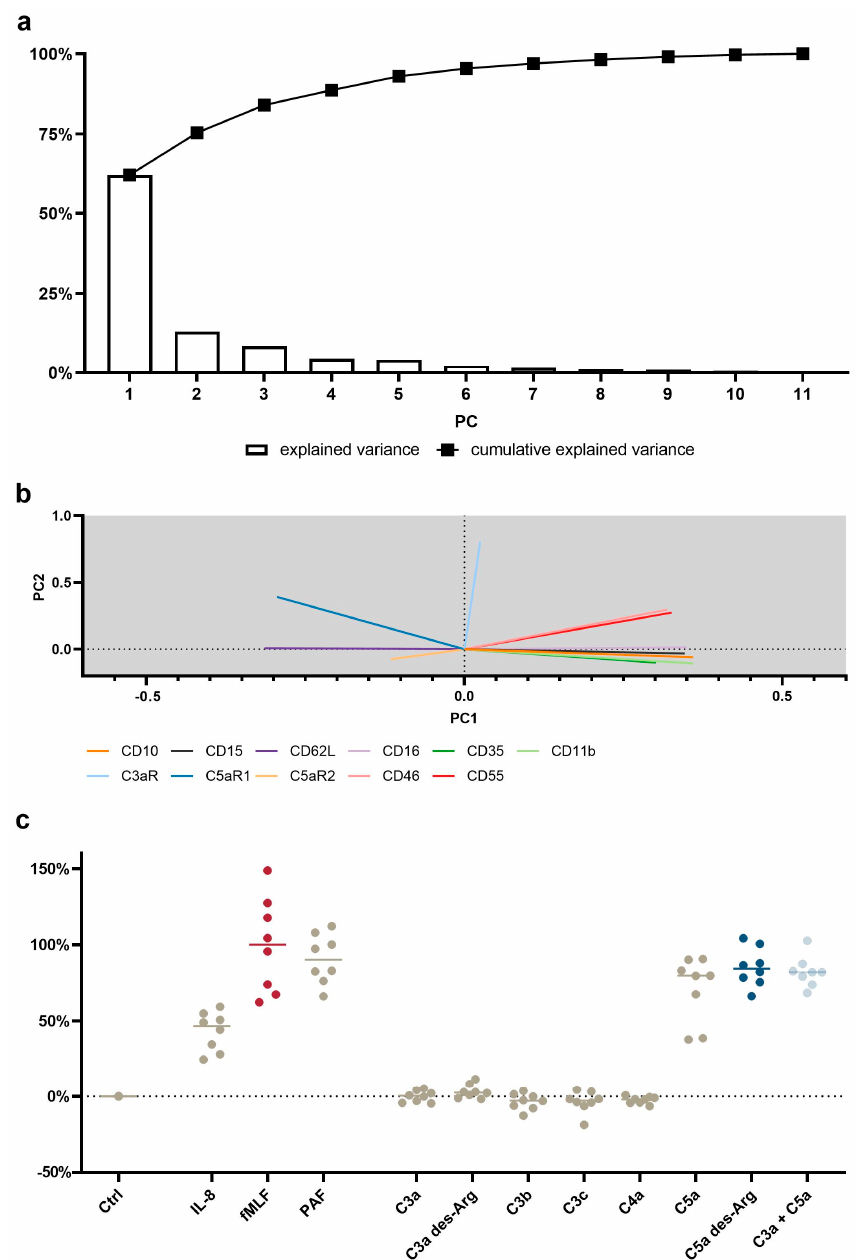
Figure 5. Principal component analysis (PCA) of the neutrophil response after stimulation with C3a, C4a, or C5a or other inflammation-related stimuli. ( a ) Scree plot reporting the explained variance per principal component (PC) and the cumulative explained variance. ( b ) Loading plot reporting the vector of the respective parameter of PC1 and PC2. The scaling of the X-axis and Y-axis represent the explained variance of 62% and 13%, respectively. ( c ) First PC normalized to 0% = unstimulated neutrophils and 100% = median of fMLF-stimulated neutrophils. The following concentrations were used: 10 nM C5a, 10 nM C5a des-Arg, 10 µ M fMLF, 50 ng/mL IL-8, 100 nM C3a, 100 nM C3a